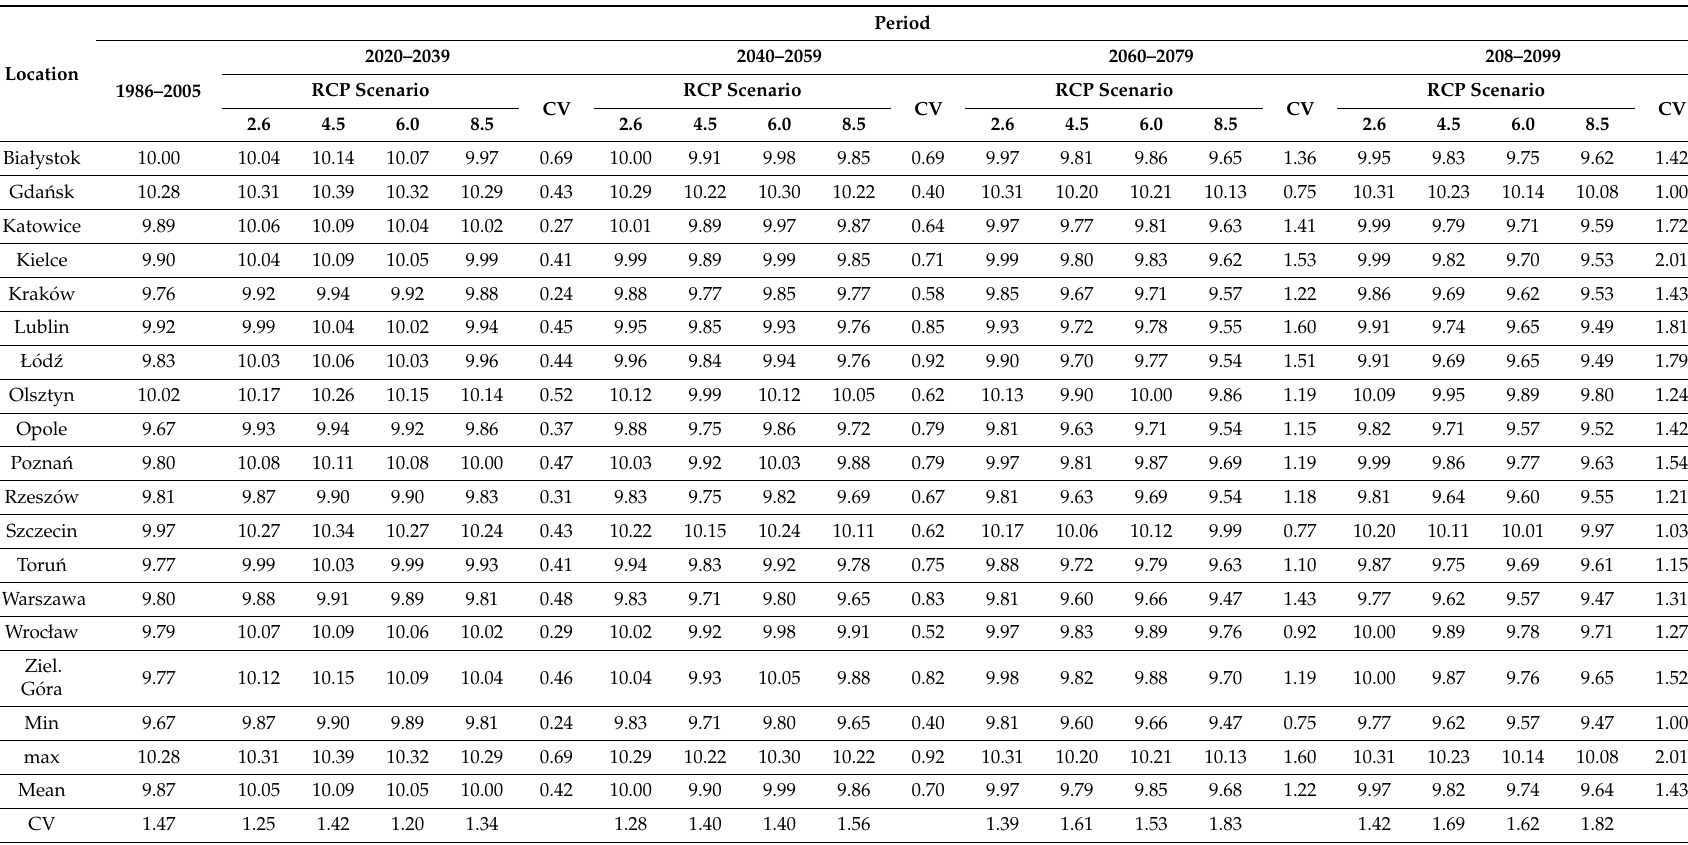
Table 12. Linolenic acid content in oilseed rape seeds calculated for the period of 1986–2005 and predicted for four RCP scenarios (2.6, 4.5, 6.0, 8.5) and four periods